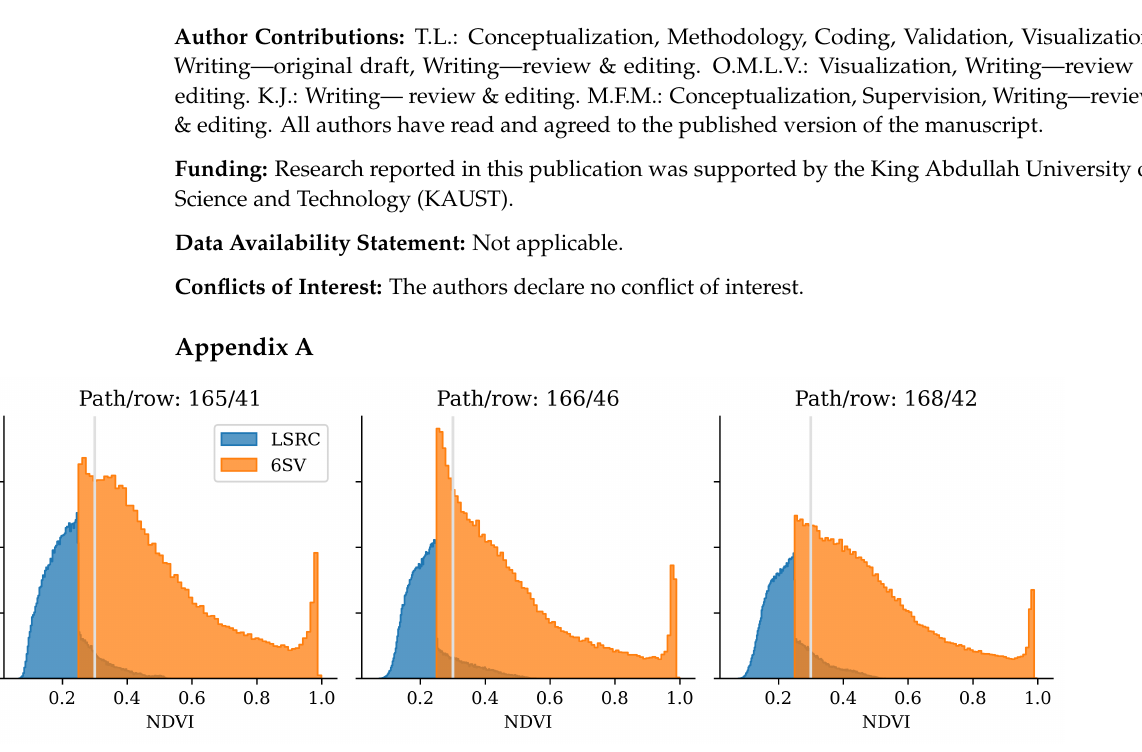
Figure A1. The NDVI distributions of pixels detected as pixels forming a center-pivot field using 6SV-